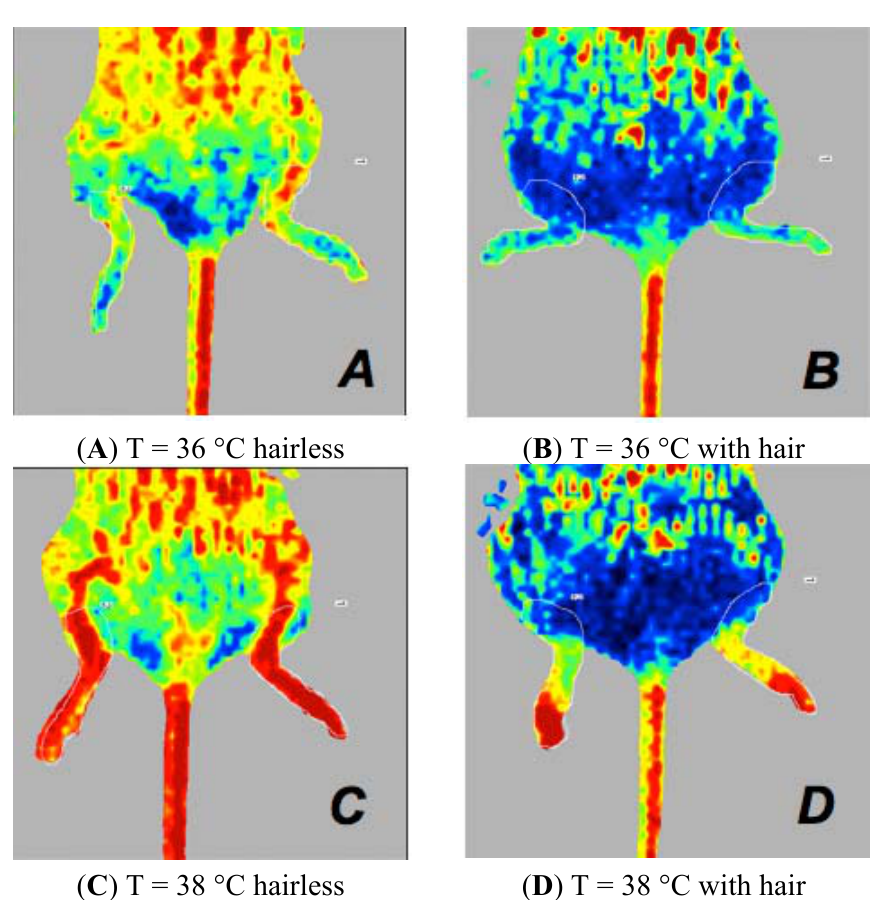
Figure 3. Laser Doppler images of the hind limbs of mice anaesthetised with isoflurane at 36 °C ( A , B ) or at 38 °C ( C , D ). Perfusion signals in mice depilated with ARC and ARD, placed in the dorsal decubitus position. ARD mice (A,C) show higher perfusion values compared to ARC mice (B,D).